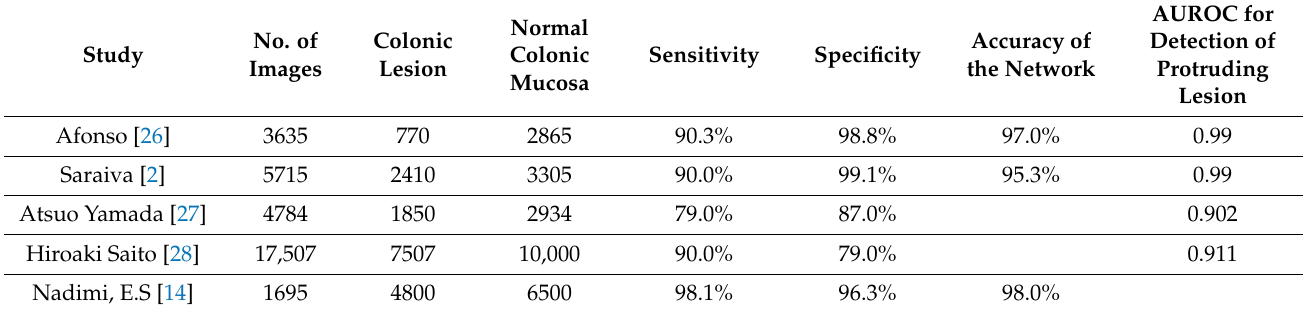
Table A1. Summary of CNN performance for detection of colonic lesions.